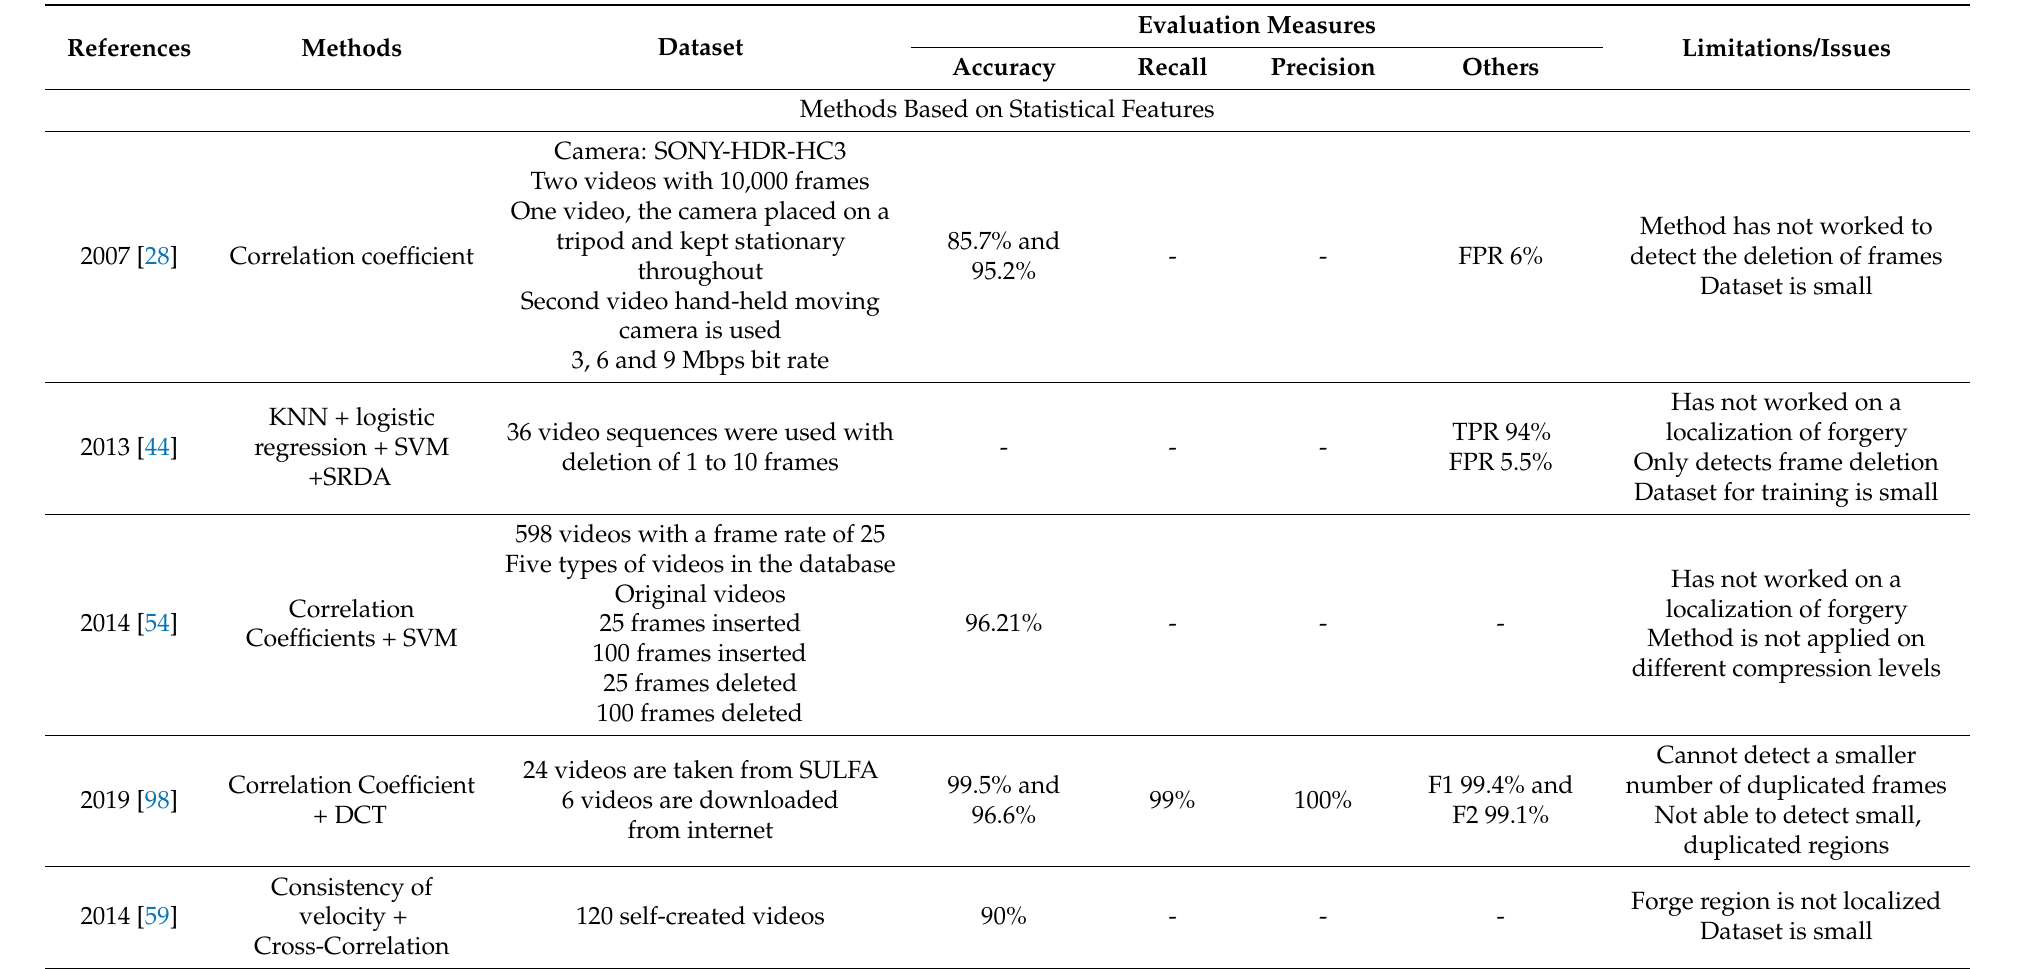
Table 4. Summary of temporal tampering (forgery) detection